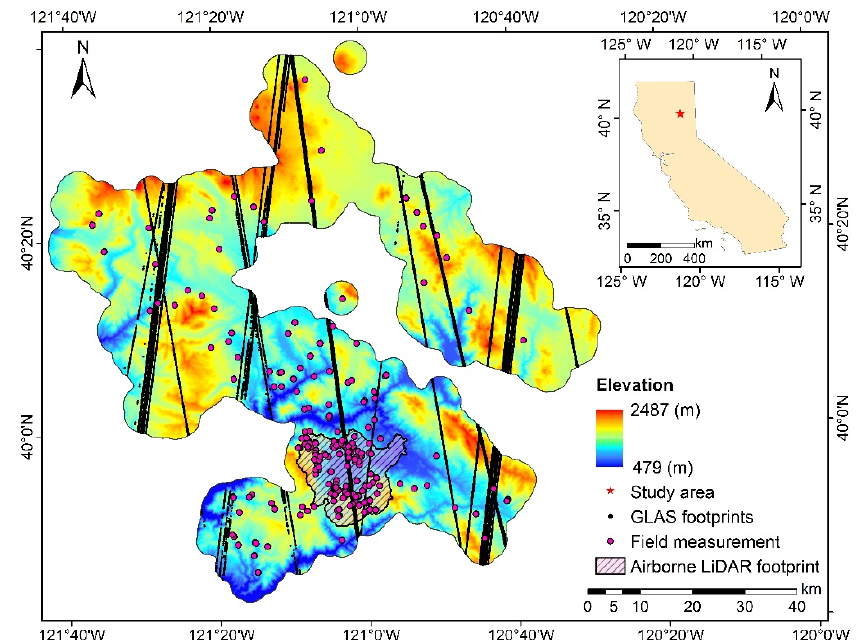
Figure 1. The location of the study area, and the distribution of Geoscience Laser Altimeter System (GLAS) footprints, airborne light detection and ranging (LiDAR) data and in-situ measurements. Note that the elevation distribution in the figure is represented by the Shuttle Radar Topography Mission (SRTM) digital elevation model